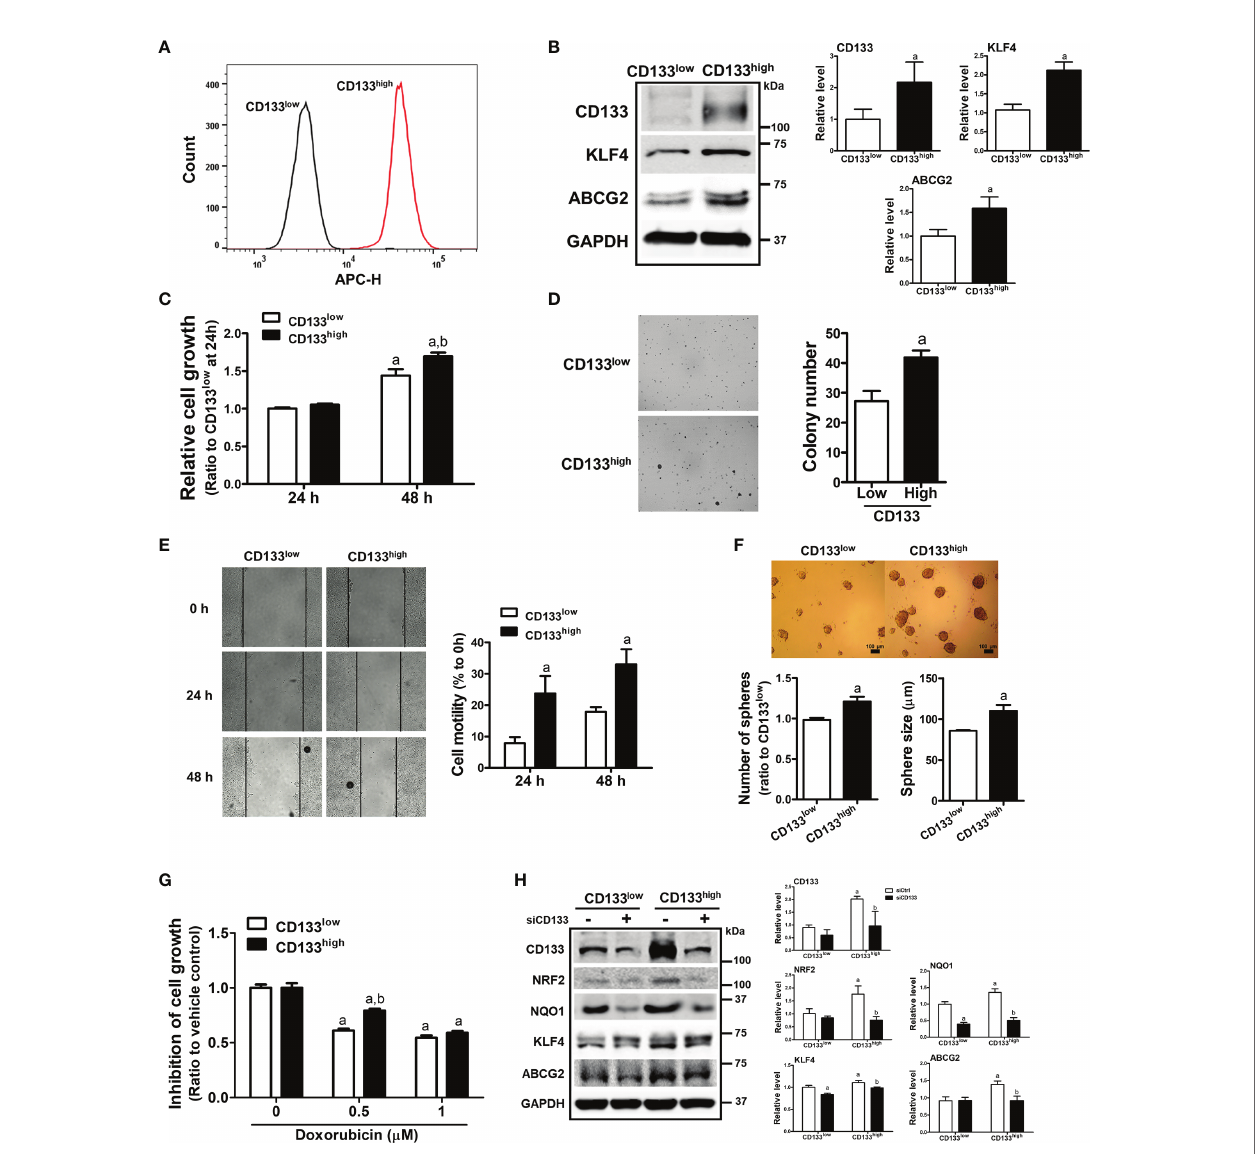
FIGURE 5 | Enhanced CSC-like properties and NRF2 levels in CD133 high HCT116 fraction. (A) CD133-positive and CD133-negative cell fractions were isolated using FACS analysis, and the CD133 high and CD133 low HCT116 cell lines were established. CD133-positive cell fraction in the CD133 high and CD133 low HCT116 cell lines was assessed following maintenance for 2 weeks. (B) Protein levels of CD133, KLF4, and ABCG2 were determined in established CD133 high and CD133 low HCT116 cells. Bar graph represents quanti fi ed protein levels from at least three experiments. a P < 0.05 compared with the CD133 low cell line. (C) The CD133 high and CD133 low HCT116 cells were grown in the absence of fetal bovine serum (FBS) and relative cell growth was assessed using MTT assay after 24 h and 48 h of plating. a P < 0.05 compared to each 24 h group. b P < 0.05 compared to CD133 low HCT116 cells. (D) The CD133 high and CD133 low HCT116 cells were suspended in the top soft agar layer (0.35% soft agar) and anchorage-independent growth was monitored for 2 weeks. Colony number was counted using an ECLIPSE Ti inverted microscope and the NIS-Elements AR (V. 4.0) software. Bar graph represents quanti fi ed results from at least three experiments. a P < 0.05 compared to the CD133 low HCT116 cells. (E) Cell migration ability was assessed in the CD133 high and CD133 low HCT116 cells using a wound-healing assay for 24 h and 48 h. Bar graph represents quanti fi ed results from at least three experiments. a P < 0.05 compared to the CD133 low HCT116 cells. (F) CD133 high and CD133 low HCT116 cells were grown in sphere culture condition, and sphere formation capacity was assessed by measuring the number and average size of the spheres. Bar graph represents quanti fi ed results from at least three experiments. a P < 0.05 compared to the CD133 low HCT116 cells. (G) Inhibition of cell growth was monitored following doxorubicin (0.5 and 1 m M) incubation for 24 h using MTT assay. Values represent the mean ± SEM from four independent experiments. a P < 0.05 compared to the doxorubicin-treated CD133 low group. (H) CD133 high and CD133 low HCT116 cells were transfected with CD133 siRNA and protein levels of CD133, NRF2, NQO1, KLF4, and ABCG2 were determined. Bar graph represents quanti fi ed protein levels from at least three experiments. Quanti fi cation results of western blotting were relative values to the loading control GAPDH. All values represent the mean ± SEM from three independent experiments. a P < 0.05 compared with the CD133 low siCtrl group. b P < 0.05 compared with the CD133 high siCtrl